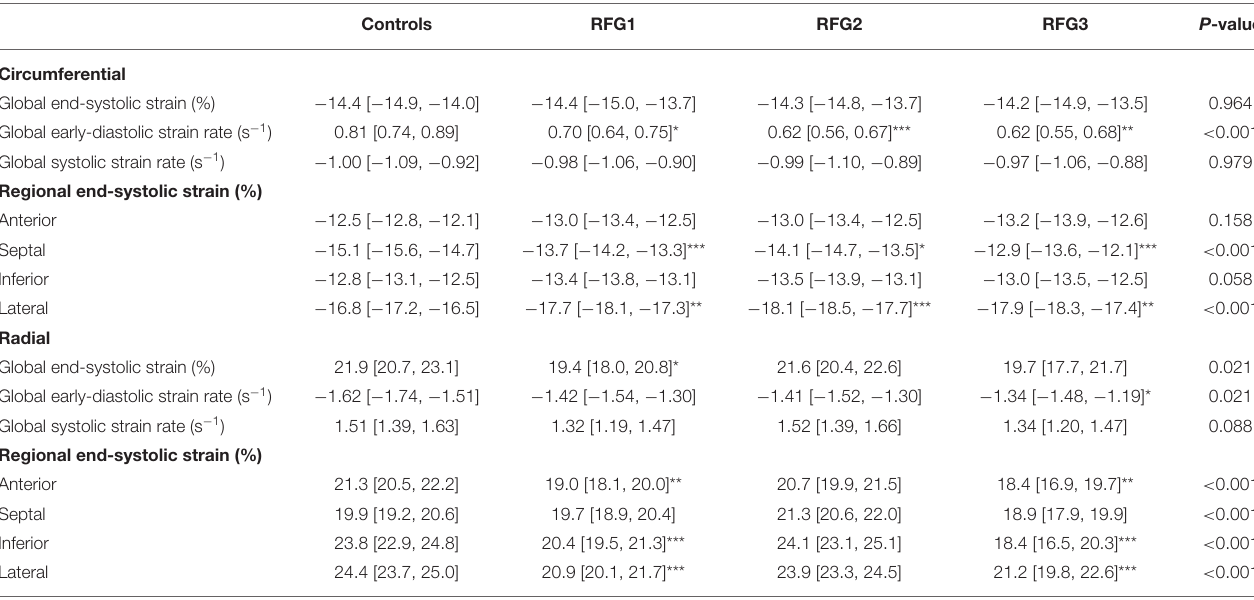
Controls RFG1 RFG2